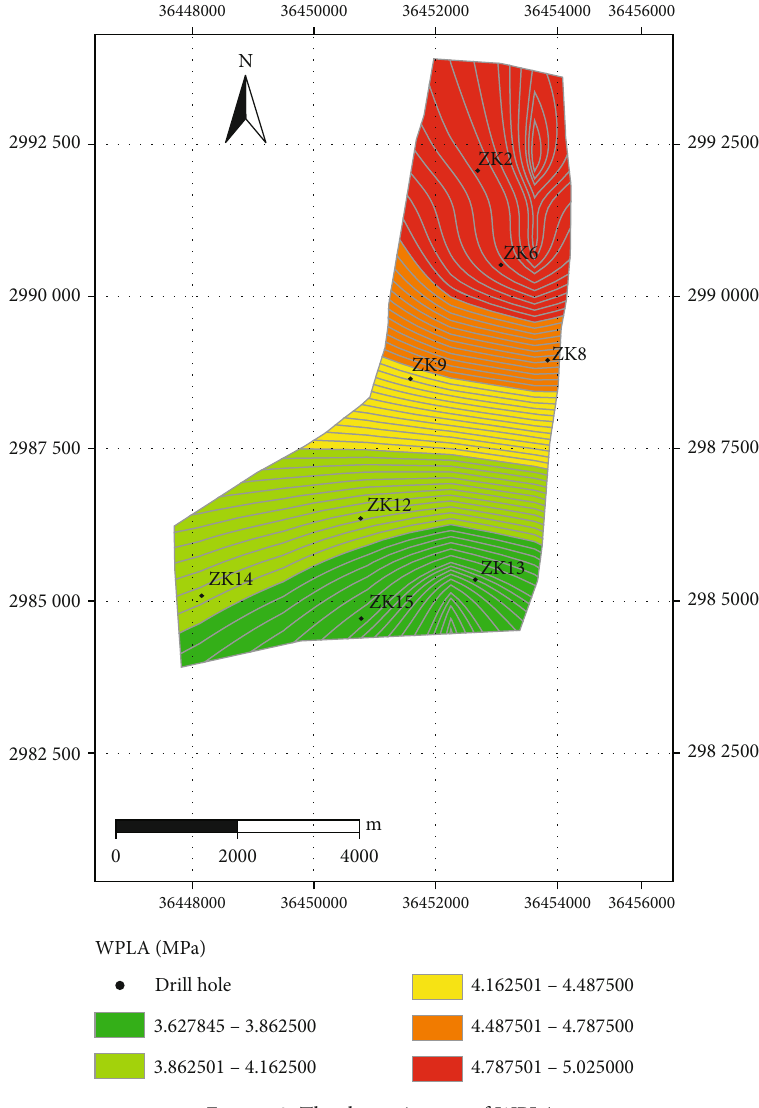
Figure 3: The thematic map of